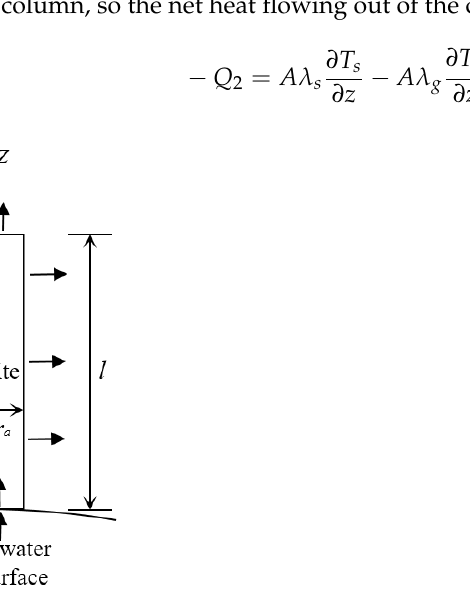
Figure 4. Geometrical model for dendrite temperature field.